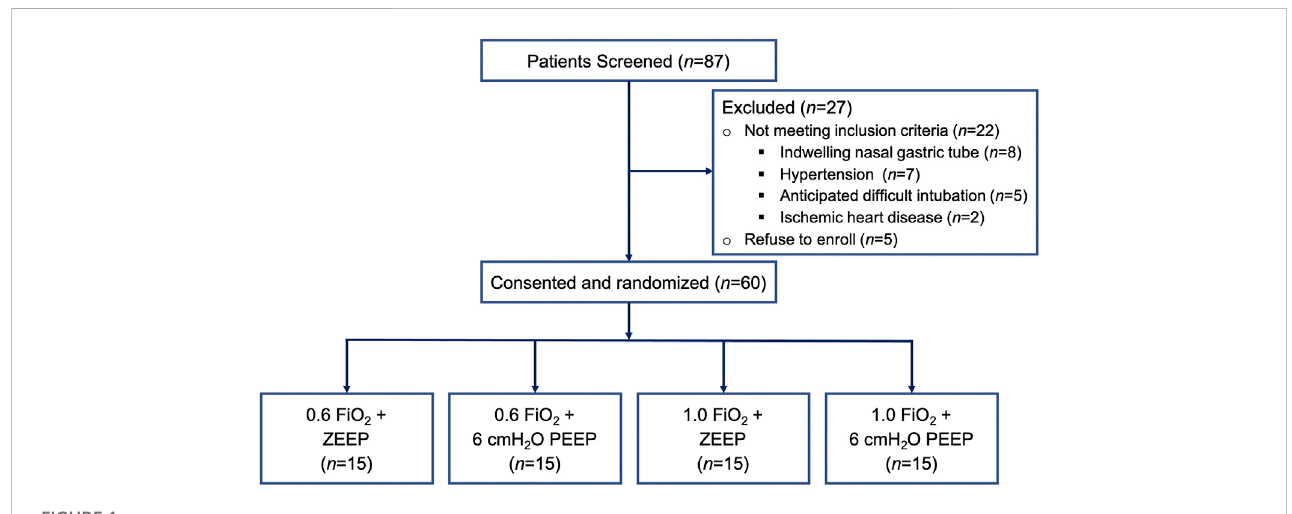
FIGURE 1 Flow chart of 87 consecutive patients that scheduled for surgery under general anesthesia during the study period. After 27 patients were excluded for reasons stated above, 60 patients were randomized to four study